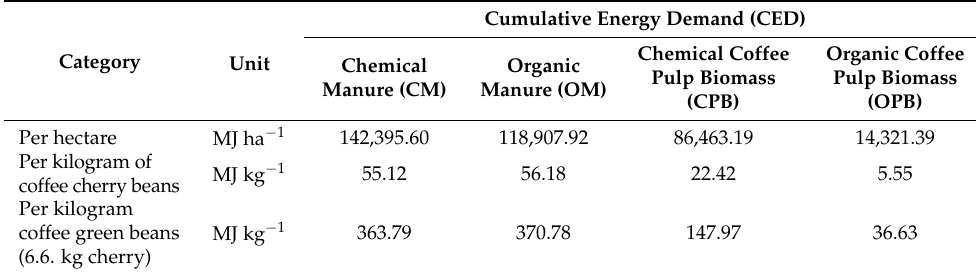
Table 1. Cumulative energy demand for coffee production at the farm